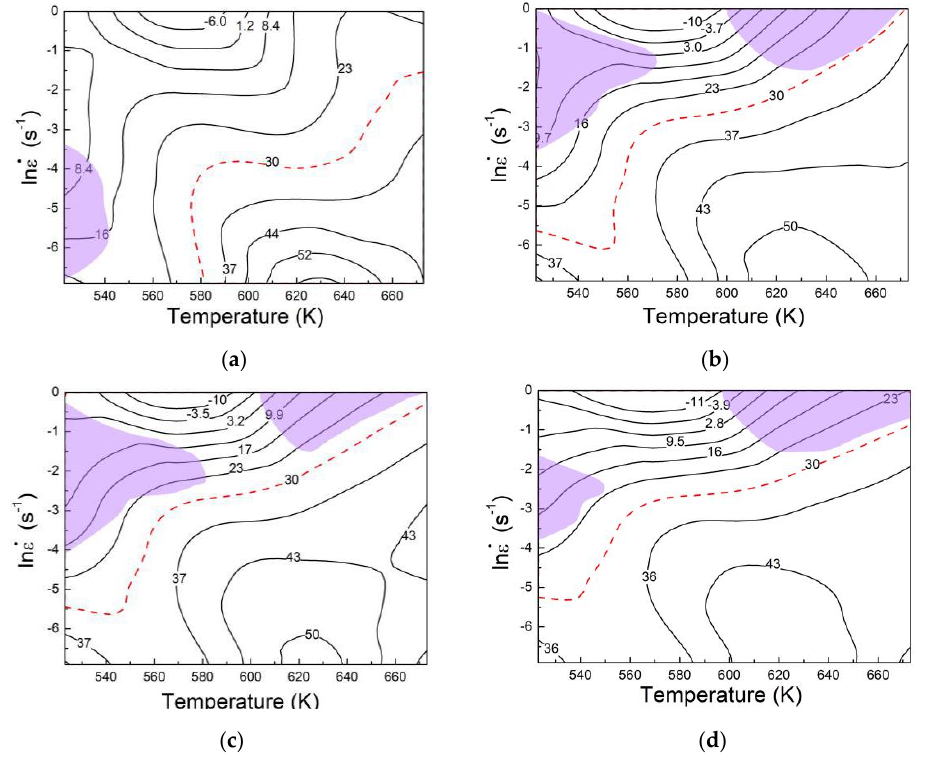
Figure 7. Processing maps of the MZCM at the strains of ( a ) 0.1, ( b ) 0.3, ( c ) 0.5 and ( d ) 0.7.